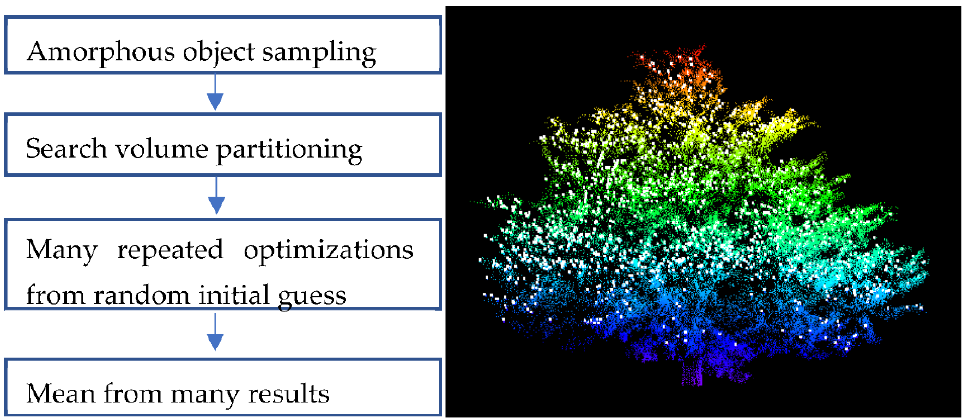
Figure 1. Brief flowchart of amorphous object method ( left ). Sampled airborne and TLS point clouds from an amorphous object ( right ).